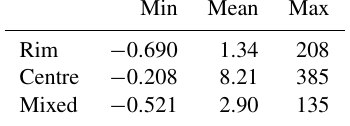
Table 3. Modelled daily methane flux for the summer periods 2003 to 2005 for the rim, centre and a mixed approach of 65% rim plus 35% centre in mg CH 4 m − 2 d − 1 , rounded to three non-zero digits. Summer means less than 5cm of snow are on the ground. Please note the different unit here. Min